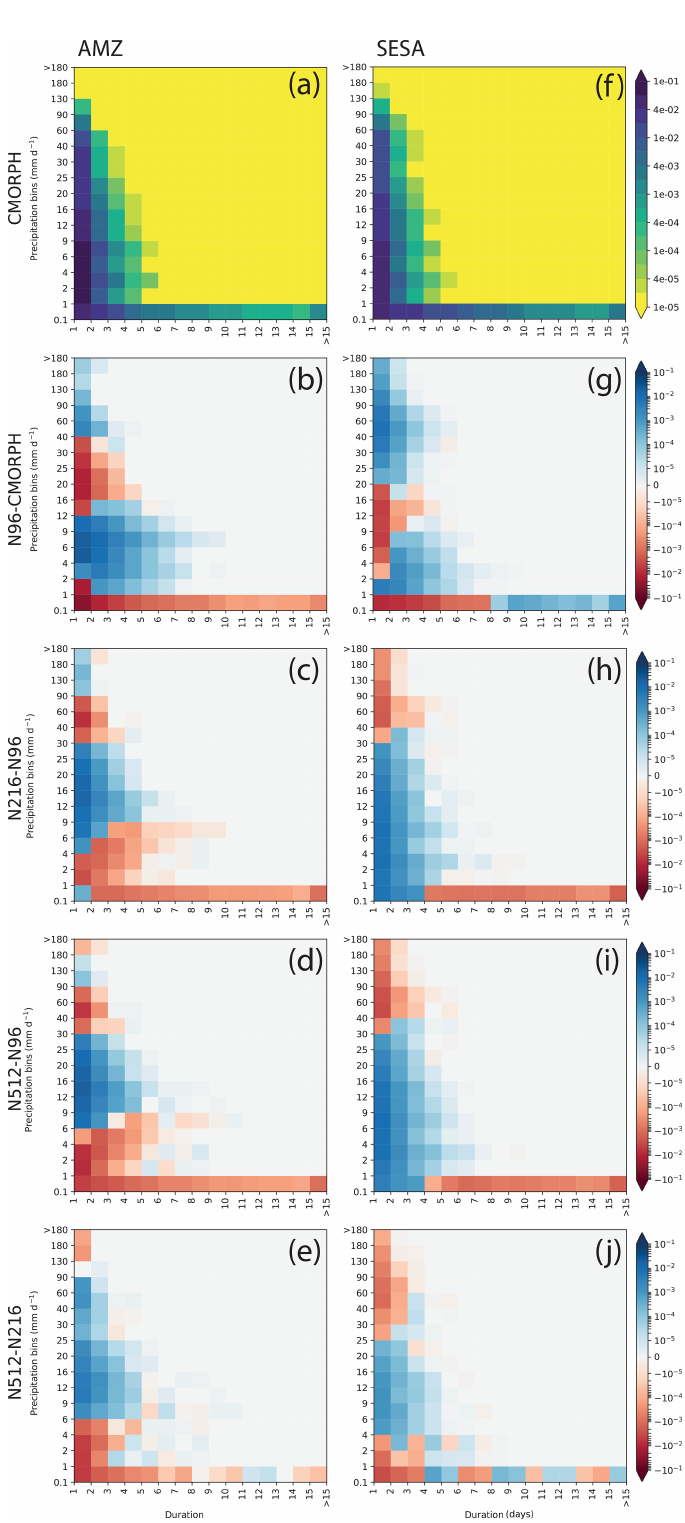
Figure 10. Two-dimensional histograms of binned precipitation lasting for each duration bin, aggregated over all grid points and normalised by the number of spatial and temporal points in each dataset for (a) CMORPH for the AMZ region at N96 grid. Differences between the two-dimensional histograms for (b) N96 minus CMORPH, (c) N216 minus N96, (d) N512 minus N96, and (e) N512 minus N216 computed on the common N96 grid. Panels (f) – (j) are the same as (a) – (e) but for the SESA